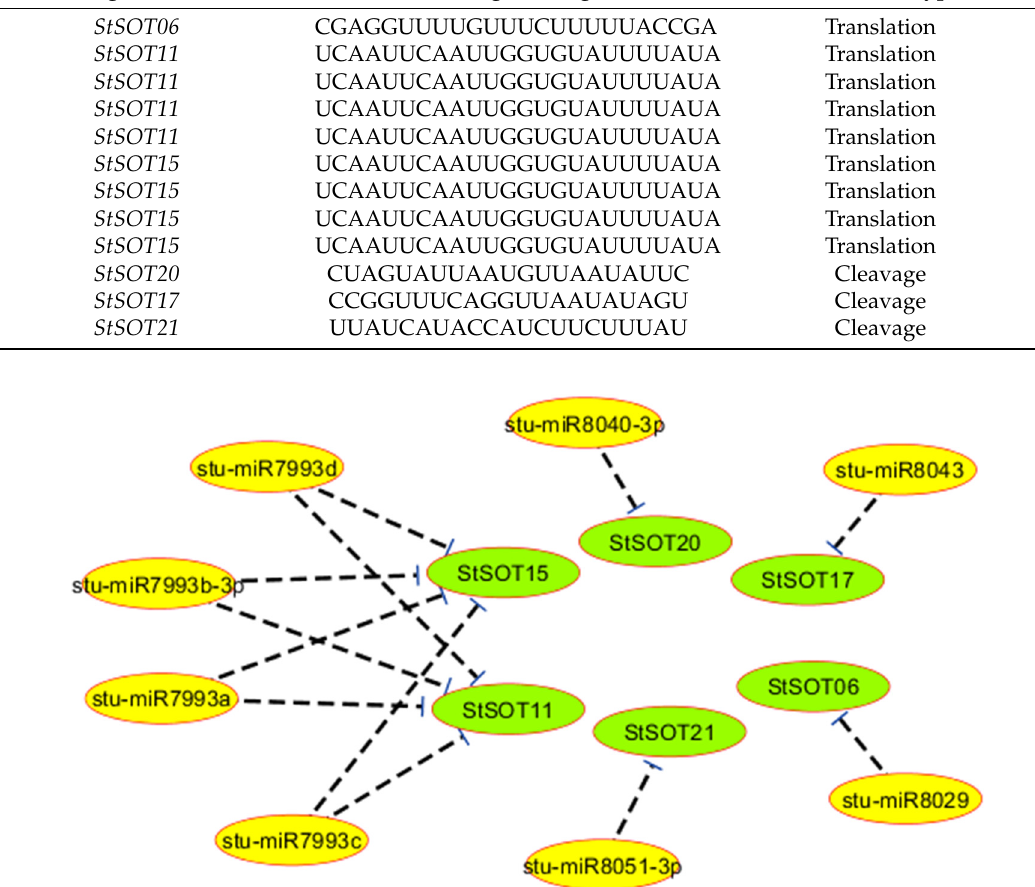
Figure 6. Interaction network between micro-RNAs and StSOT